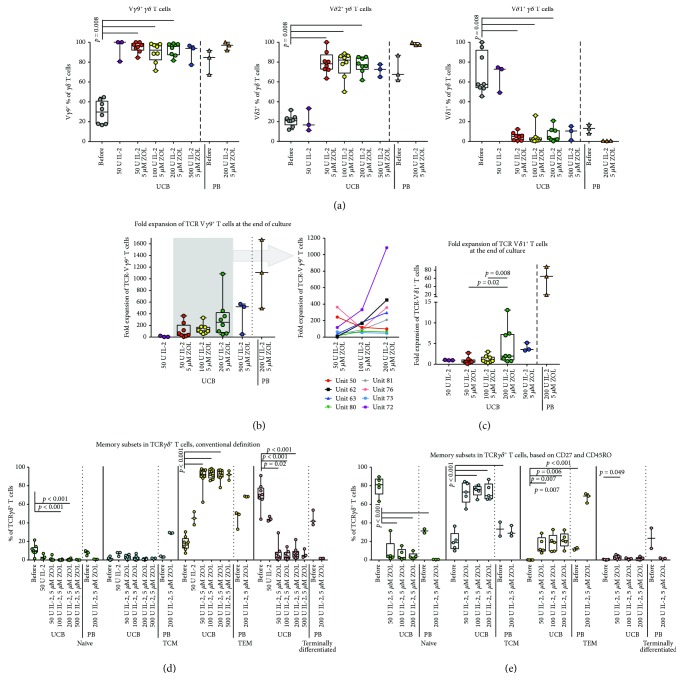

γδ chain usage and memory phenotype in cultured γδ T cells. Phenotype of the cultured γδ T cells. The phenotype of the γδ T cells with regard to the expression of memory markers and specific γ and δ chains was assessed by flow cytometry. In (a), the percentage of γδ T cells positive for Vγ9 (left panel), Vδ2 (middle panel), and Vδ1 (right panel) is shown. The fold expansion of Vγ9+ T cells and Vδ1+ T cells is displayed in (b) and (c), respectively. In (b), the grey box in the left graph contains the UCB γδ T cells cultured with 5 μM zoledronate and 50, 100, or 200 IU IL-2/ml medium, and in the right graph, indicated by the arrow, the data inside the box is displayed separately for each cultured UB unit (each unit is indicated by a differently colored line). The memory phenotype of the γδ T cells before and after culture, using a definition based on the expression of CD45RO and CCR7, is displayed in (d). Naïve T cells were defined as CD45RO− CCR7+, central memory as CD45RO+ CCR7+, effector memory as CD45RO+ CCR7−, and terminally differentiated cells were defined as CD45RO− CCR7−. The memory phenotype, defined by the expression of CD45RO and CD27, is displayed in (e). Naïve T cells were defined as CD45RO− CD27+, central memory T cells as CD45RO+ CD27+, effector memory T cells as CD45RO+ CD27−, and terminally differentiated T cells as CD45RO− CD27−. IL-2: interleukin 2; TCM: central memory T cells; TCR: T cell receptor; TEM: effector memory T cells; ZOL: zoledronate.